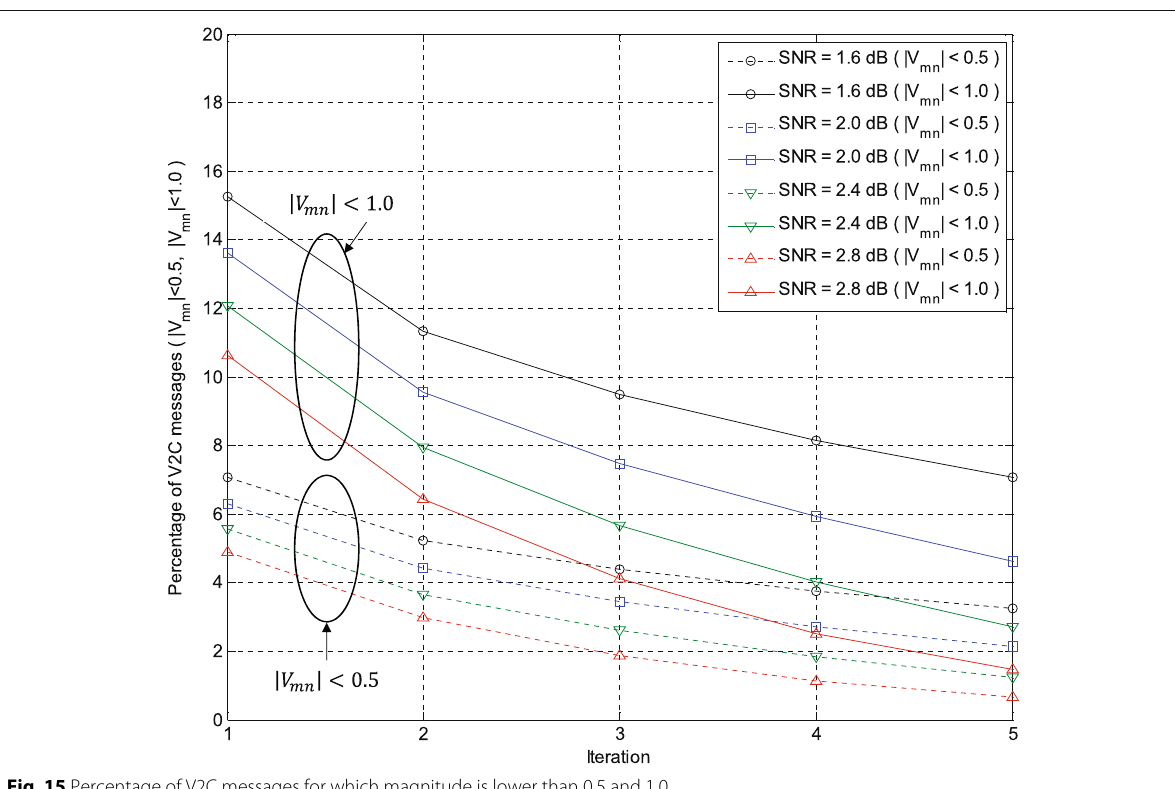
Fig. 15 Percentage of V2C messages for which magnitude is lower than 0.5 and